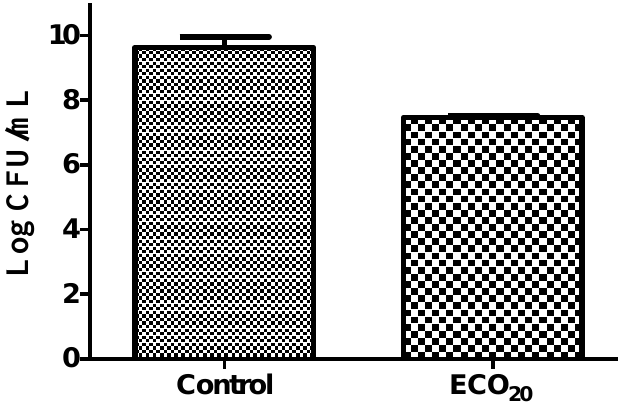
Figure 5. Total S. aureus count expressed in log CFU/mL.